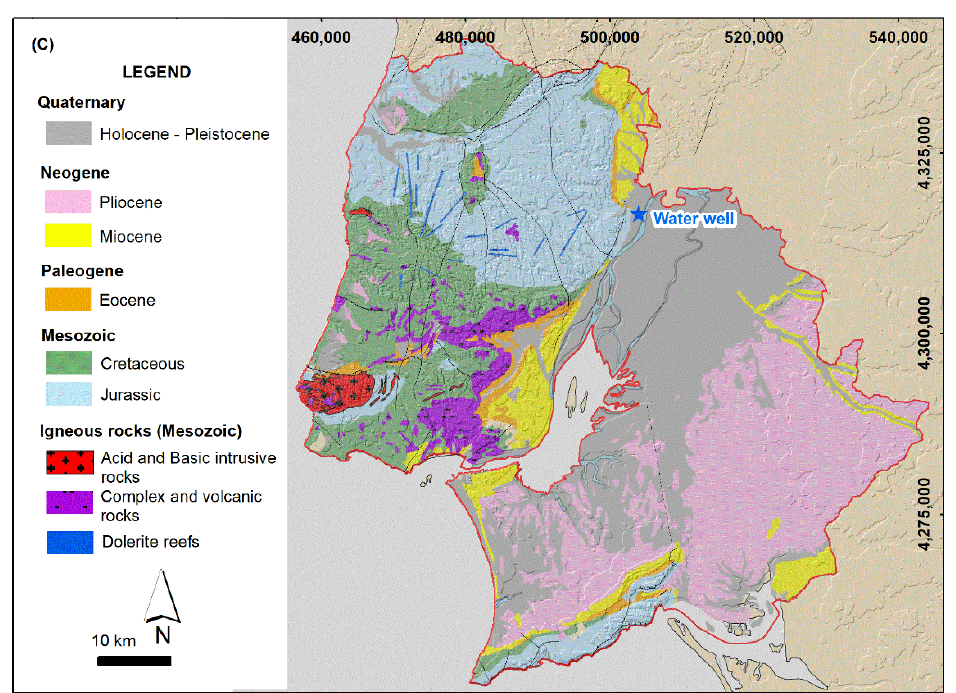
Figure 1. ( A ) Location of Lisbon metropolitan area in the southwest of Portugal. ( B ) Lisbon metropolitan area and the 18 municipalities and location of the S. Julião do Tojal Meteorological Station.